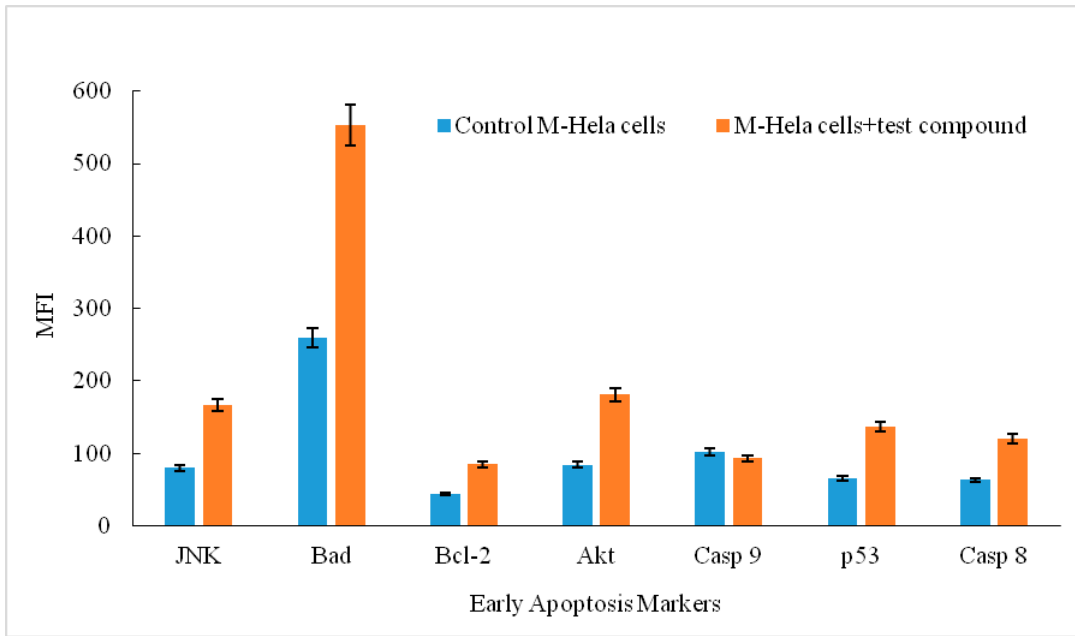
Figure 4. Multiplex analysis of early apoptosis markers in M-Hela cells treated with the test 6g at an IC 50 concentration of 14.7 µ M as well as M-Hela cells untreated with the test substance (control). substance 6g at an IC 50 concentration of 14.7 µM as well as M-Hela cells untreated with the test The median fluorescence intensity (MFI) was measured using the Luminex ® system. The graph shows substance (control). The median fluorescence intensity (MFI) was measured using the Luminex ® the mean and standard deviation values for the wells in triplicate. system. The graph shows the mean and standard deviation values for the wells in triplicate.